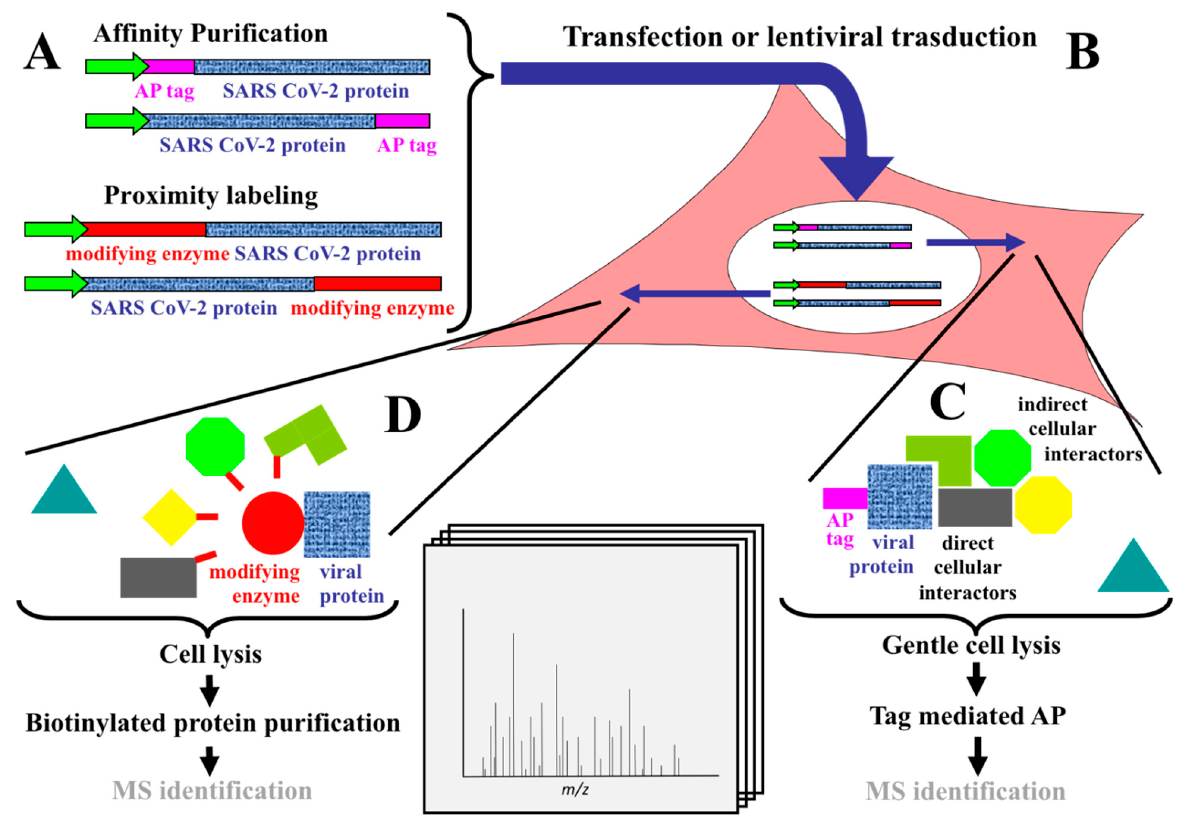
Figure 1. Schematic representation of (protein–protein interaction) PPI identification strategies. (A) In the Affinity Purification (AP) strategy, the sequence coding for the viral protein (shown in blu) is fused in frame, either at the N- or at the C-terminus, with a peptide tag (shown in purple) which, for the investigations here reviewed, can be Strep [17,18], FLAG [19,20] or HA [21]. In the proximity labeling strategy, the sequence coding for the viral protein is fused in frame, either at the N- or at the C-terminus, with a biotin protein ligase modifying enzyme (shown in red). In all cases, a promoter (green arrow) drives the expression of the fusion protein. (B) The constructs described in (A) are transferred to the test cell line which, for the investigations here reviewed, can be HEK-293 cells [17–20,23,24] or A549 cells [21,22] by mean of transfection (either transient [17–20] or stable [23,24]) or by lentiviral mediated transduction [21,22]. In the test cell line, the promoter of the construct drives the expression of the fusion protein. (C) In the AP strategy, following gentle cell lysis, the cellular preys (here shown in different colors and shapes) interacting, either directly or indirectly, with the viral bait are affinity purified, usually using a monoclonal antibody specific for the AP tag (shown in purple). If a cellular protein (indicated by a triangle) does not interact with the viral bait, it is not affinity purified at this stage. Finally, after AP, specifically bound proteins are digested and identified by mass spectrometry (MS). (D) In the proximity labeling approach, after expression of the fusion protein (here shown as a blue square, representing the viral protein, fused with a red circle, representing the modifying enzyme) in the test cell, the biotin protein ligase modifying enzyme mediates the “promiscuous” biotinylation (shown in red) of proteins (here shown in different colors and shapes) in close proximity (~5–10 nm) to the enzyme. If a cellular protein (indicated by a triangle) is not in proximity with the enzyme-viral bait fusion protein, it is not biotinylated. Following cell lysis, only biotinylated proteins are purified by streptavidin and then identified by MS.